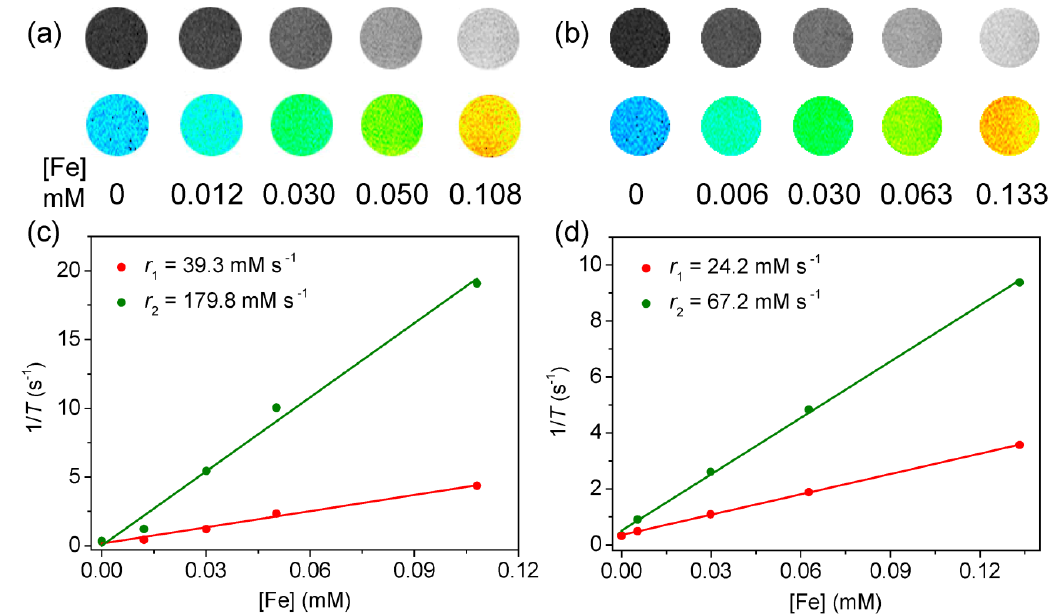
Figure 3. T 1 -weight phantom images of ( a ) Fe 3 O 4 -BSA and ( b ) Fe 3 O 4 -PMAA-PTTM nanoparticles with various Fe concentrations. Plot of 1/ T over Fe concentration of ( c ) Fe 3 O 4 -BSA and ( d ) Fe 3 O 4 -PMAA-PTTM nanoparticles. The slopes indicate the relaxivity of r 1 (red line) and r 2 (green